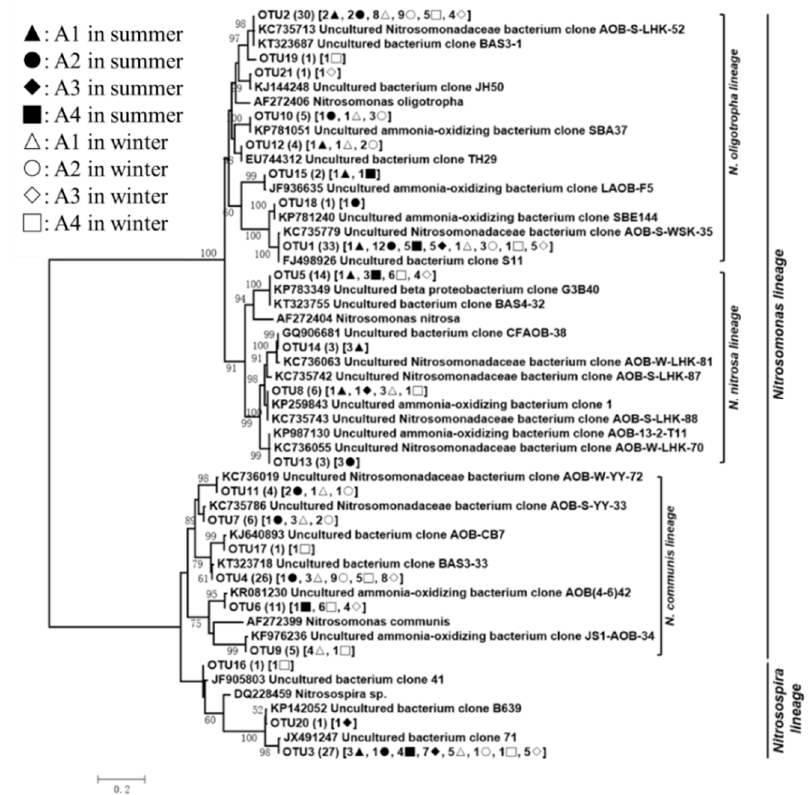
Figure 3. Neighbor-joining phylogenetic tree based on the nucleotide sequences of the amoA gene. The numbers at the nodes represent the credible values that were calculated from 1000-times bootstrap tests. Bootstrap values greater than 50% were shown. The scale bar indicated 0.2 substitutions per nucleotide position. GenBank accession numbers were shown for sequences from other studies. Numbers in parentheses following each OTU indicated the number of sequences recovered from each sampling site.